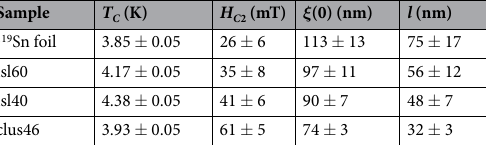
Table 2. Sample characteristics extracted from the superconducting phase boundaries: critical temperature (